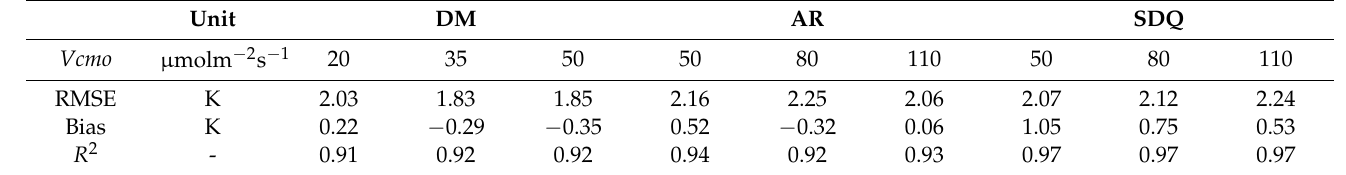
Table 3. Statistical information of SCOPE-simulated results using different Vcmo